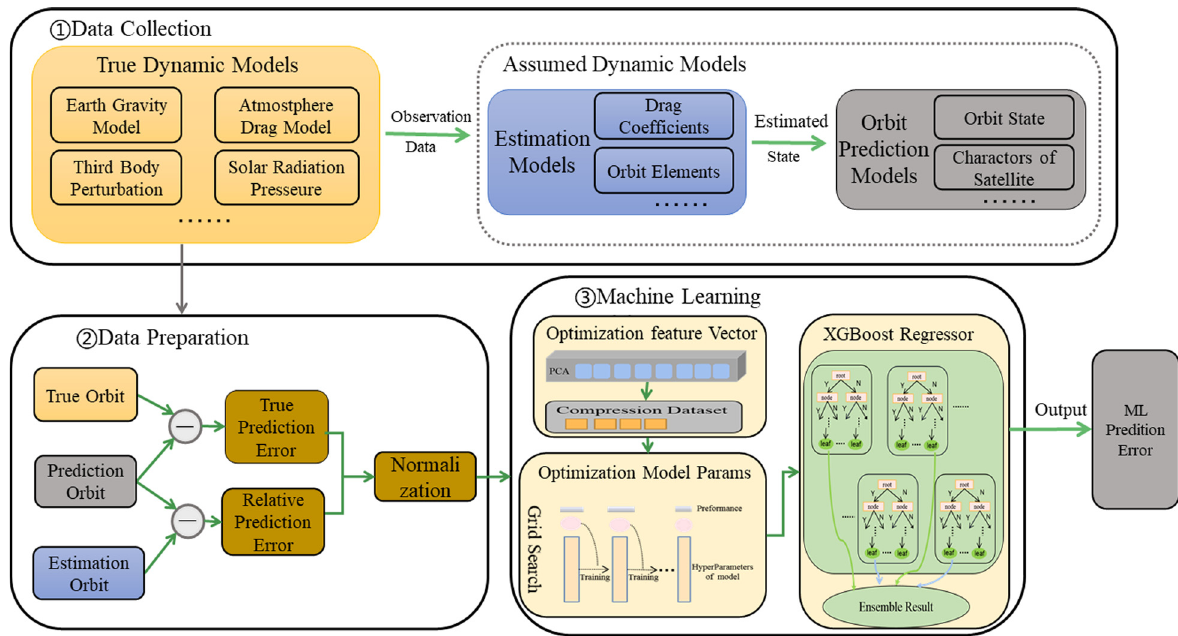
Figure 1: The framework of the proposed PCA – XGBoost model. “ True Orbit ” is generated by using the true dynamic model, “ Predicted Orbit, ” and “ Estimated Orbit ” are generated using the assumed dynamic model. “ Estimated Orbit ” is determined from the observation data generated by using the assumed dynamic model. “ Predicted Orbit ” is propagated from “ Estimated Orbit. ” The proposed model tries to learn the underlying relationship between the relative prediction errors and true prediction errors, whose output is the correction of future predicted orbit.